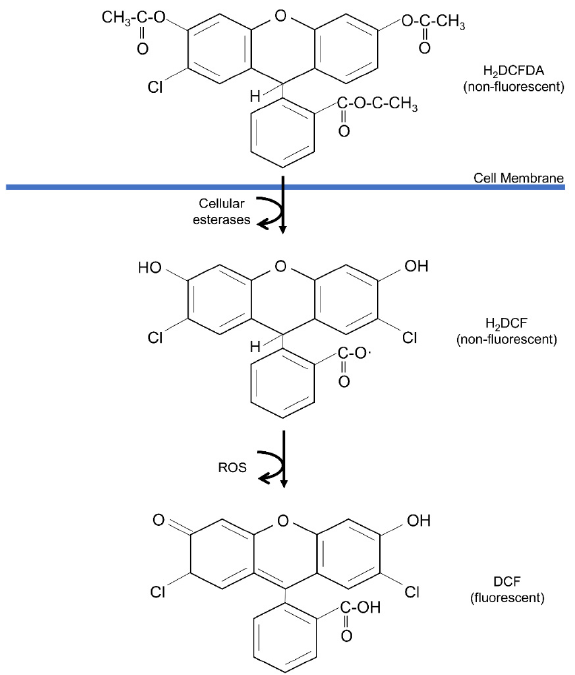
Figure 8. The chain reaction of DCFDA assay where the molecules become highly fluorescent after reacting with reactive oxygen species. The image is adapted from Nova et al. [176] and license under CC BY 4.0.